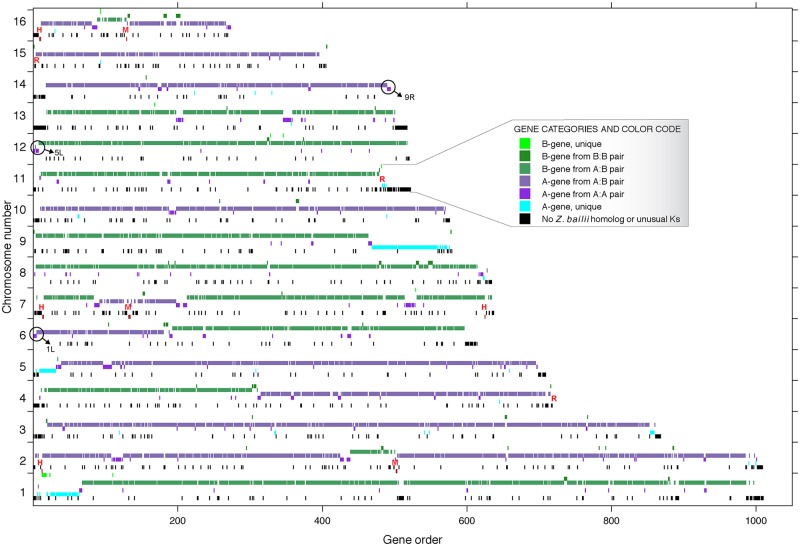
Subgenome and duplication status of each Z. parabailii gene.Each gene was classified into 1 of 7 categories and color-coded as shown in the legend. For each chromosome, 7 rows were then drawn, showing the locations of genes in each category (the 7 rows appear in the same order from top to bottom as in the legend). “R” shows the locations of ribosomal DNA (rDNA clusters). “M” and “H” indicate the locations of MAT and HML/HMR loci. Circles with arrows mark the 3 chromosome ends where our sequence is incomplete due to break-induced replication (BIR); in each case, the missing sequence is apparently identical to the end of another chromosome, as shown. For example, we infer that at the right end of chromosome 14, our assembly artefactually lacks a second copy of the genes that are labeled as “A unique” on the right end of chromosome 9. The high sequence identity of the chromosome 9 and 14 copies of this region caused them to coassemble, and the coassembled contig was arbitrarily assigned to chromosome 9.